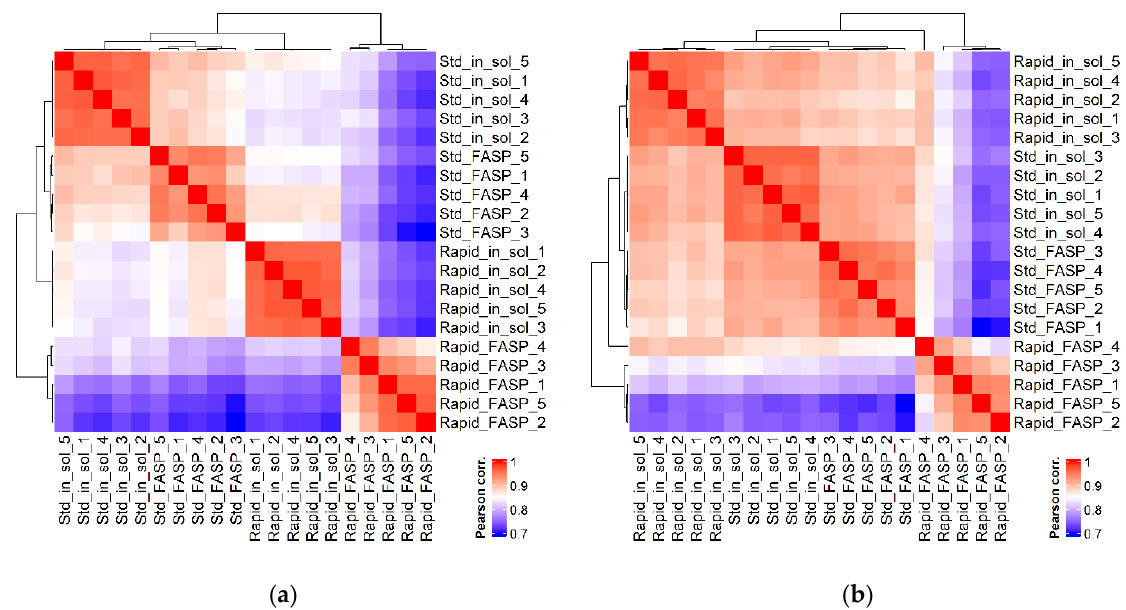
Figure 9. Replicate clustering based on correlation. Hierarchical clustering heatmap of Pearson correlation coefficients between dataset replicates for peptide ( a ) and PG ( b ) intensities. Correlations are colored on a scale from red (1.0, maximal possible correlation) to blue (0.7, lower correlation). Numerical values are shown in Supplemental materials (Correlations_peptides.xlsx and Correla- tions_proteins.xlsx). Std_in_sol — standard in-solution digestion; Rapid_in_sol — rapid in-solution digestion; Std_FASP — standard filter-aided preparation; Rapid_FASP — rapid filter-aided preparation. Rapid FASP was demonstrated to be the most divergent from other datasets and showed the lowest Pearson correlation coefficient between the individual replicates.